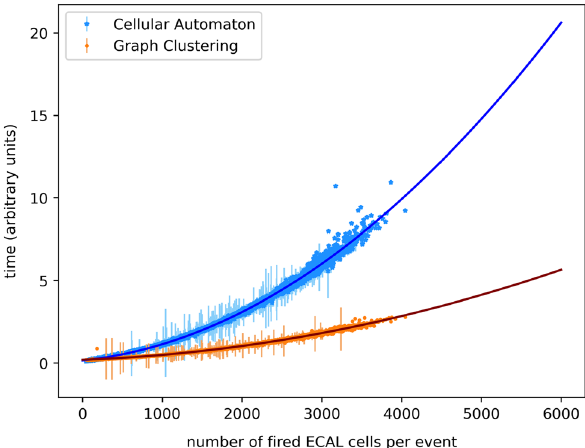
Fig. 7 Execution time measured in arbitrary units as a function of the number of digits per event for the Cellular Automaton algorithm and the Graph Clustering algorithm. On top of them, a fitted curve for every algorithm is